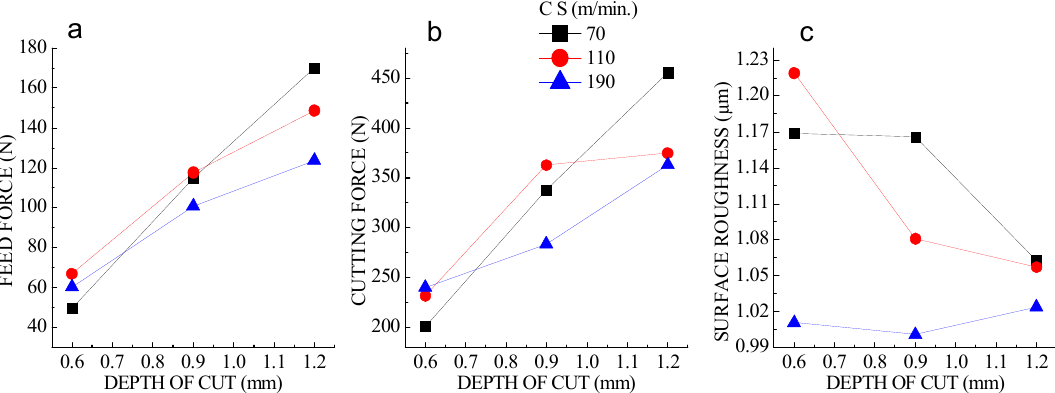
Figure 6. Graphs of ( a ) depth of cut vs. feed force; ( b ) depth of cut vs. cutting force; and ( c ) depth of cut vs. surface roughness at 0.07 mm/rev feed rate.